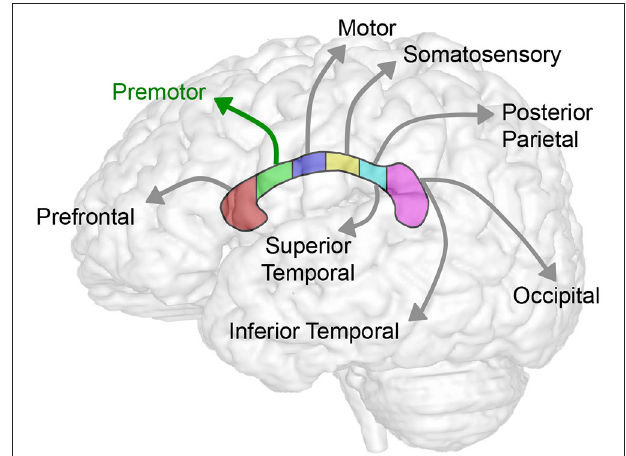
FIGURE 5 | Summary schematics of corpus callosum to forebrain homotopic-like projections. Schematic illustrates homotopic projections between corpus callosum and the forebrain sub-regions. In this study, we showed consistent decrease in volumes across sub-regions of CC ( Table 2 ; Figure 3 ) and forebrain ( Table 3 ; Figure 4 ) in selected group of infants following complex perioperative critical care for long-gap esophageal repair. Global decrease of the volumes appears least affected in the region II of the CC (viz. rostral body of the CC) known to project to the premotor cortex (green arrow) following esophageal repair with Foker process. Interestingly, a disproportionally smaller normalized volume of subgenual sub-region of the forebrain (not illustrated; see Figure 2C ) does not have any direct homotopic connections via